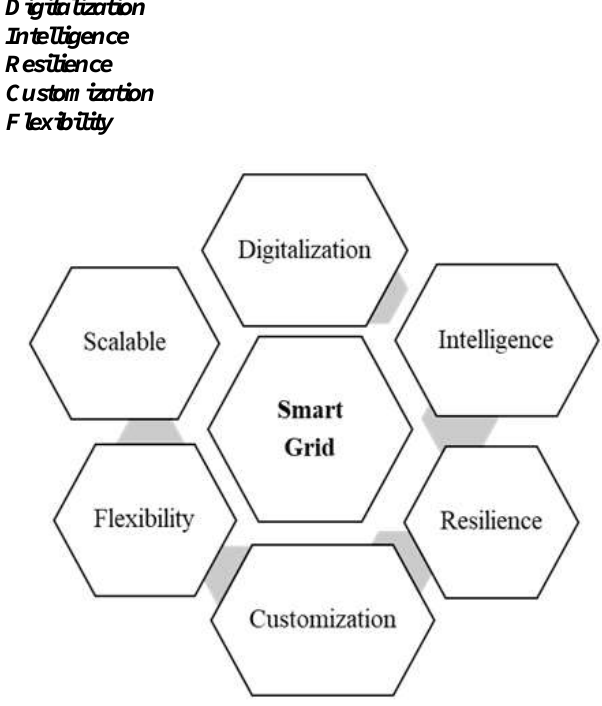
Figure 1 Smart grid properties